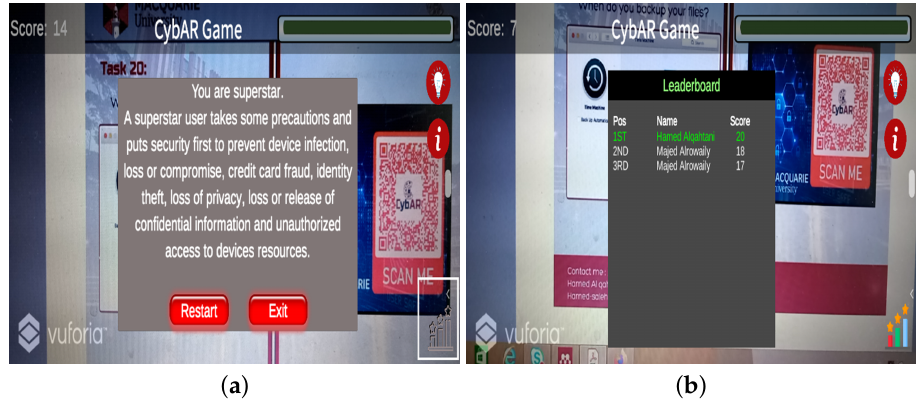
Figure 11. ( a ) Leaderboard button. ( b ) Leaderboard (top scores).